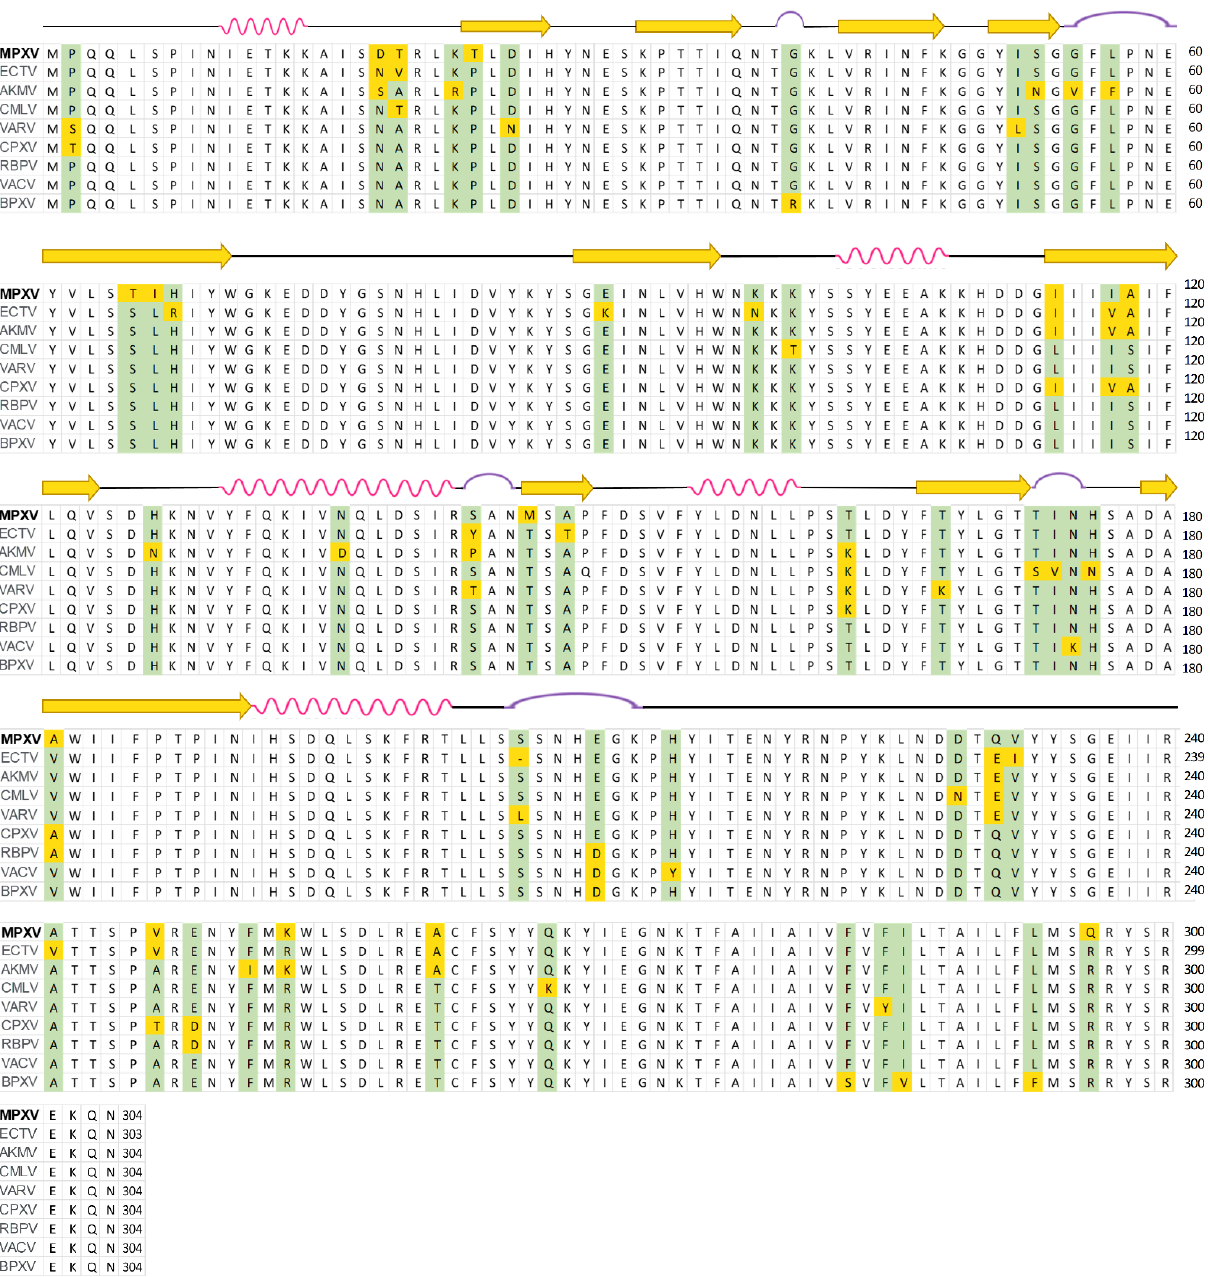
Figure 1. Multiple sequences alignment of the MPXV E8 protein with their orthologs from other members of the Orthopoxvirus genus. The alignment was performed on the Clustal Omega web server (https://www.ebi.ac.uk/Tools/msa/clustalo/) (accessed on 24 July 2022). Green and yellow highlights indicate residue differences between the viruses. Secondary structures are described at the top of the MSA for MPXV E8 protein (yellow arrow: β - sheet; pink loops: α -helices; purple curve: turn). The protein sequences used in the MSA were retrieved from the UniProt server with the cor- responding UniProt ID: Monkeypox virus (MPXV-Q8V4Y0); Ectromelia virus (ECTV-Q83439); Akhmeta virus (AKMV-A0A346FRL4); Camelpox virus (CMLV-C9E783); Variola virus (VARV- P0DSY2); Cowpox virus (CPXV-A0A1S5WL42); Rabbitpox virus (RBPV-Q6RZI9); Vaccinia virus (VACV-P20508); Buffalopox virus (BPXV-D0U6N1).